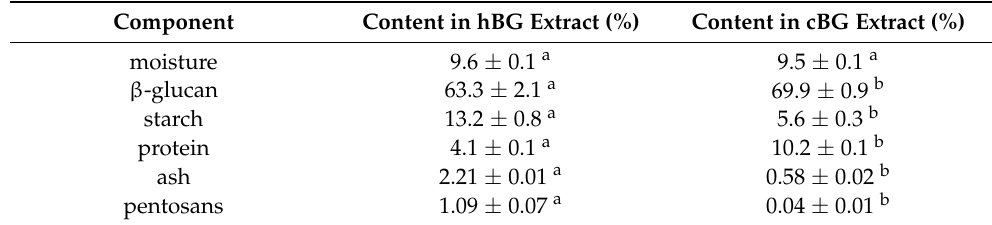
Table 1. Approximate composition of high molar mass (hBG) and control (cBG) β -glucan extracts from two commercial barley flours #